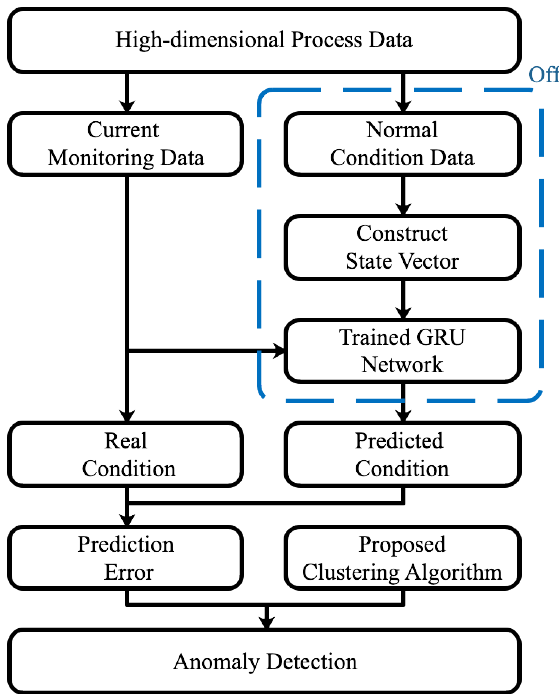
Figure 4. Schematic of the proposed data-driven